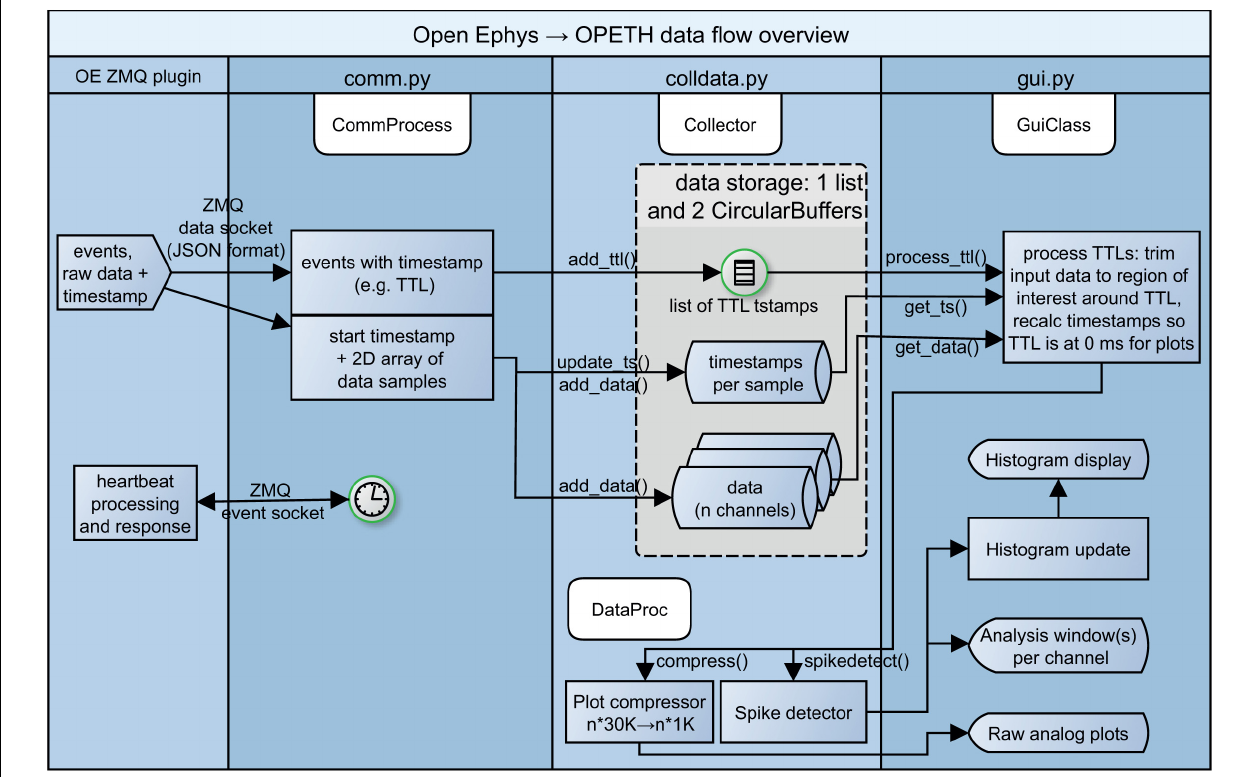
FIGURE 4 | Simplified diagram of data flow. From left to right: heartbeat messages to Open Ephys, events, raw recorded data and heartbeat responses from Open Ephys processed by the communication and data handling layers of OPETH, presented in the